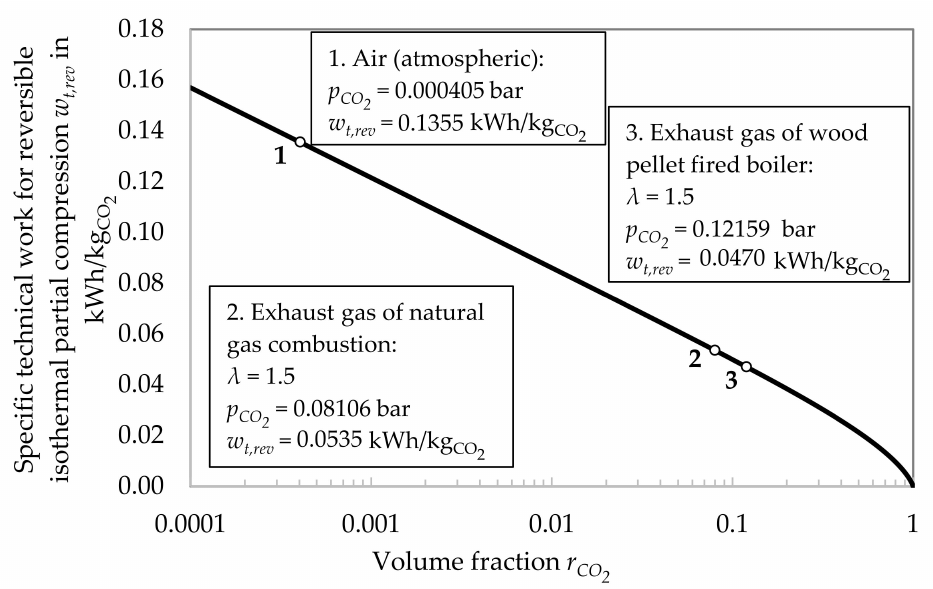
Figure 3. Energy demand for CO 2 removal with rev. isothermal partial compression over r CO